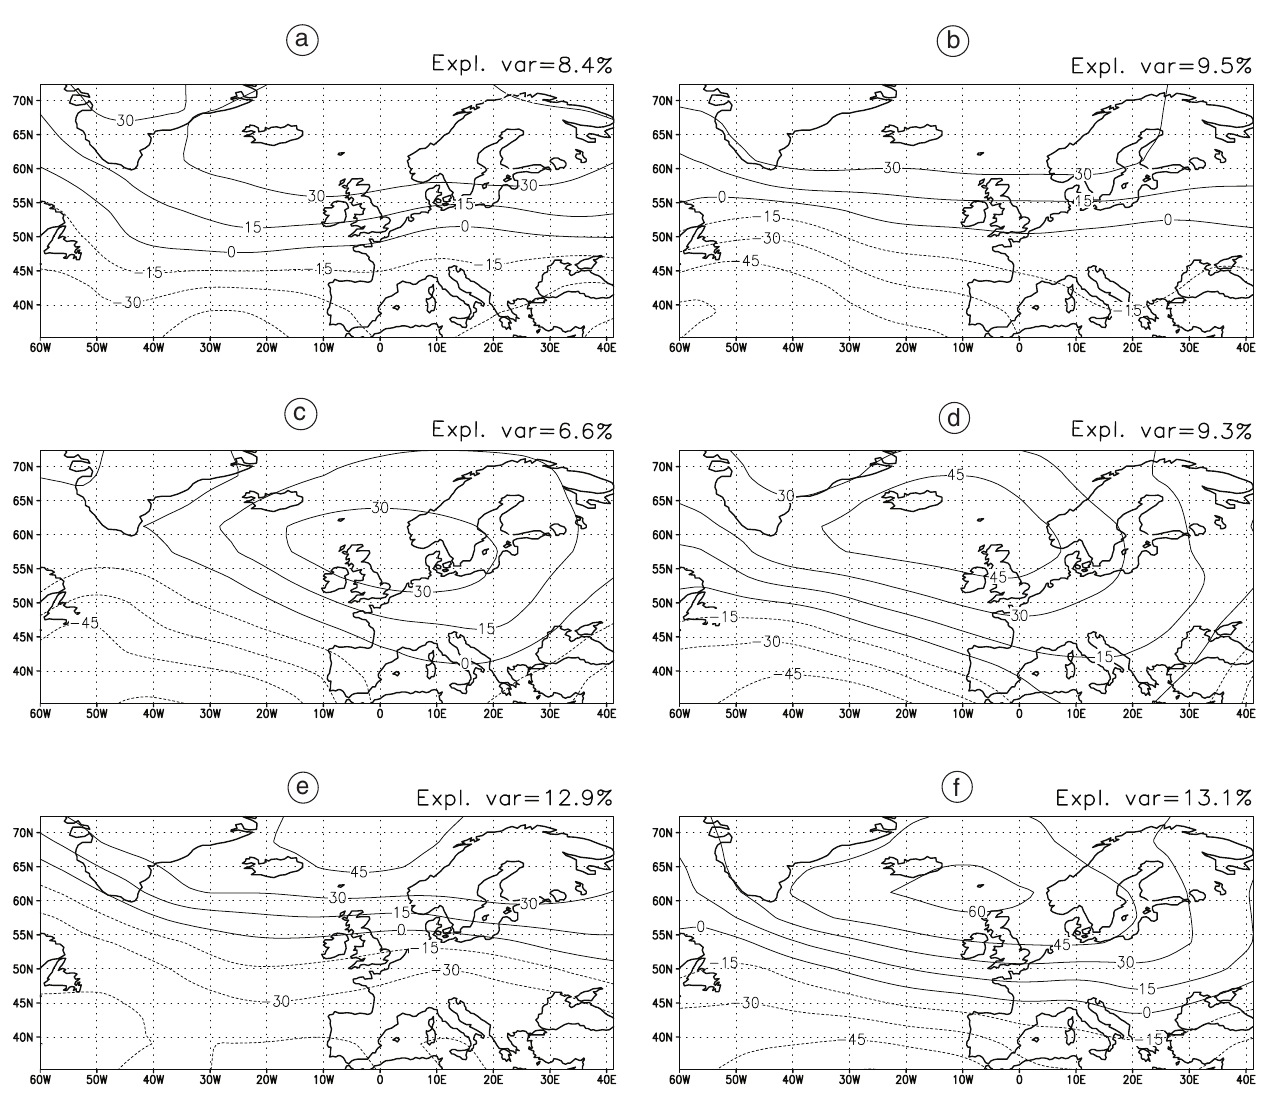
Fig. 11a-f. Leading MSLP heterogeneous correlation patterns from SVD analyses of six different 50-year periods of model simulated JFM seasonal mean tropical SST and JFM seasonal mean Atlantic/European MSLP. a) Years 1-50; b) years 51-100; c) years 101-150; d) years 151-200; e) years 201-250; f) years 251-300. Total explained MSLP variance fractions in the Atlantic/European region vary between 6.6% and 13.1%. Cf. fig. 5a which is based on an SVD analysis of all 301 model